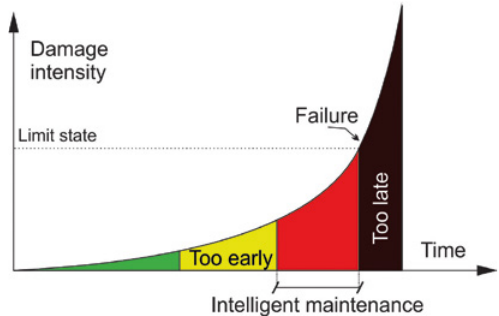
Figure 2. The concept of intelligent